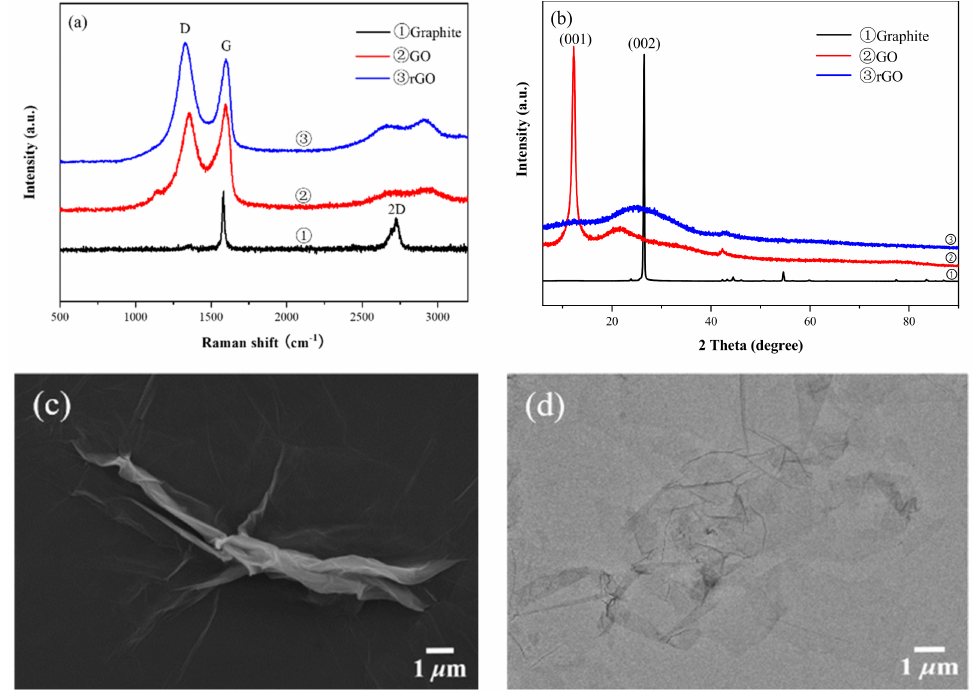
Figure 5. ( a ) Raman spectra and ( b ) XRD spectra of graphite, GO, and rGO; ( c ) SEM and ( d ) TEM image of rGO.